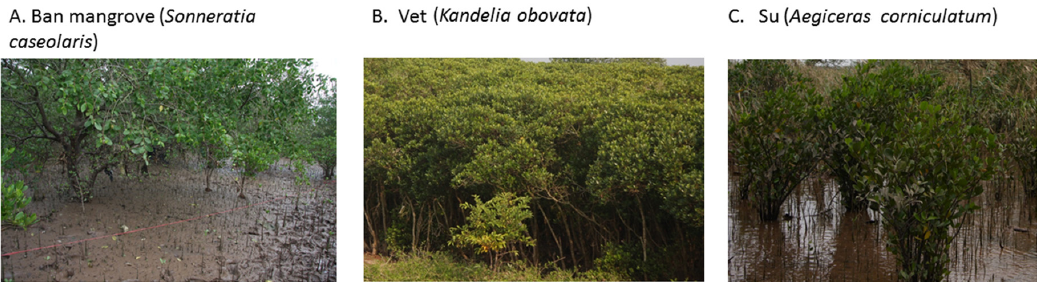
Figure 10. Pictures of three mangrove species taken by the authors in Thuy Truong commune on 22 November 2018.